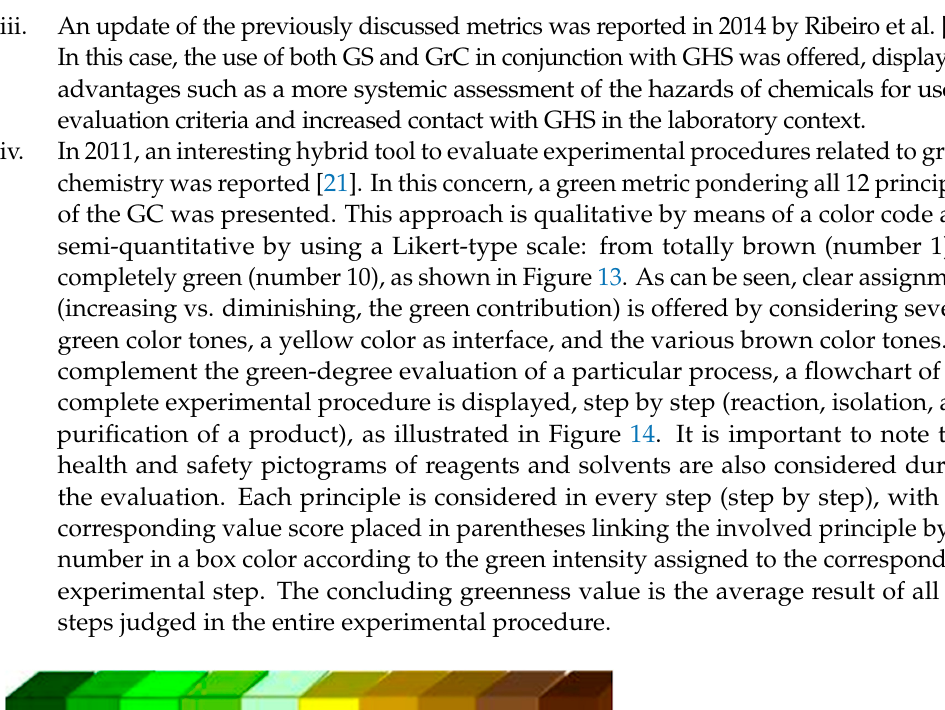
Figure 14. Example of flowchart of the experimental procedure using the Color-Likert scale for eval- uation of green chemistry principles. Adapted from Ref. [21].